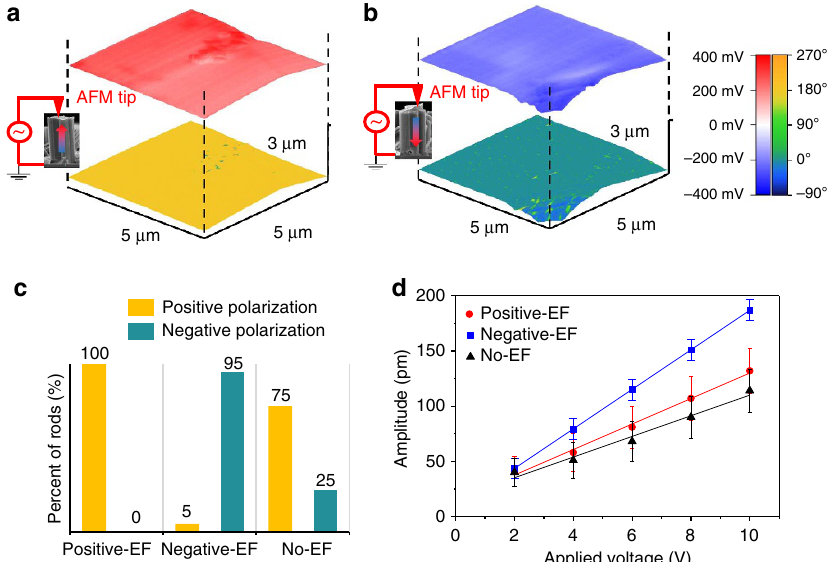
Figure 2 | PFM and SKPM characterization of the microrod arrays. ( a , b ) PFM phase image and corresponding SKPM surface potential map of a microrod from the positive-EF growth ( a ) and a microrod from the negative-EF growth ( b ). The phase and surface potential distributions are shown by the colour overlaid on the topography of the top of the microrod. ( c ) Statistics of the piezoelectric phase for the arrays from the positive-EF growth, negative-EF growth and no-EF growth. Detailed data for this chart is provided in Supplemental Table 1. ( d ) Linear dependence of the PFM amplitude on the applied voltage for FF peptide microrods from growth with different electric fields. The slopes of the lines provide effective piezoelectric coefficients d 33 , which are 17.9, 11.7 and 9.3pmV (cid:2) 1 for microrods from the negative-EF growth, positive-EF growth and no-EF growth, respectively. Error bar: Characterization of power generation . We investigated the shown in Fig. 3c,d. Under an applied force F ¼ 60 N, the output power generation using FF peptide microrods with controlled open-circuit voltage ( V oc ) and short-circuit current ( I sc ) reached 1.4 V and 39.2 nA, respectively. FF peptide microrods from polarizations. The FF peptide microrod array was sandwiched negative-EF growth produced opposite voltage and current between two electrodes that connected to an external load or outputs, and FF peptide microrods from no-EF growth produced measuring instruments, as shown in Fig. 3a. When the device was much smaller output (Supplementary Fig. 5). The signs of compressed and released, FF peptide microrods converted the open-circuit voltage and short-circuit current under compressing mechanical energy into electricity. The device characterization force all agree with the polarization direction measured from set-up in Fig. 3b includes a closed-loop linear motor with a load PFM. Reversed connection tests show that all outputs are reversed cell. A periodic compressive force was applied on the (Supplementary Fig. 6). The switching-connection test excluded power generator for 1 s and released for 2 s (Fig. 3b). The power the errors from the variation of contact resistance or parasitic generation of FF peptide microrods from positive-EF growth is